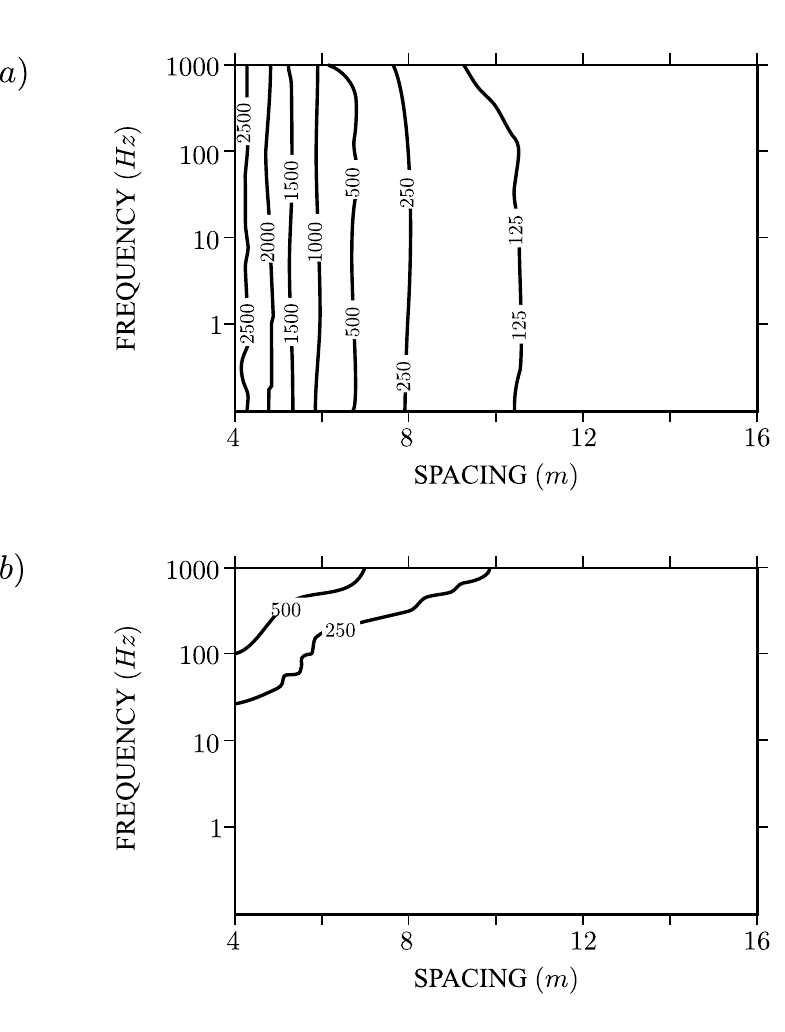
Fig. 2 – Variation of (a) the real part and (b) the imaginary part of the electric field on the sea surface, in nV/m/mA as a function of frequency and lateral spacing